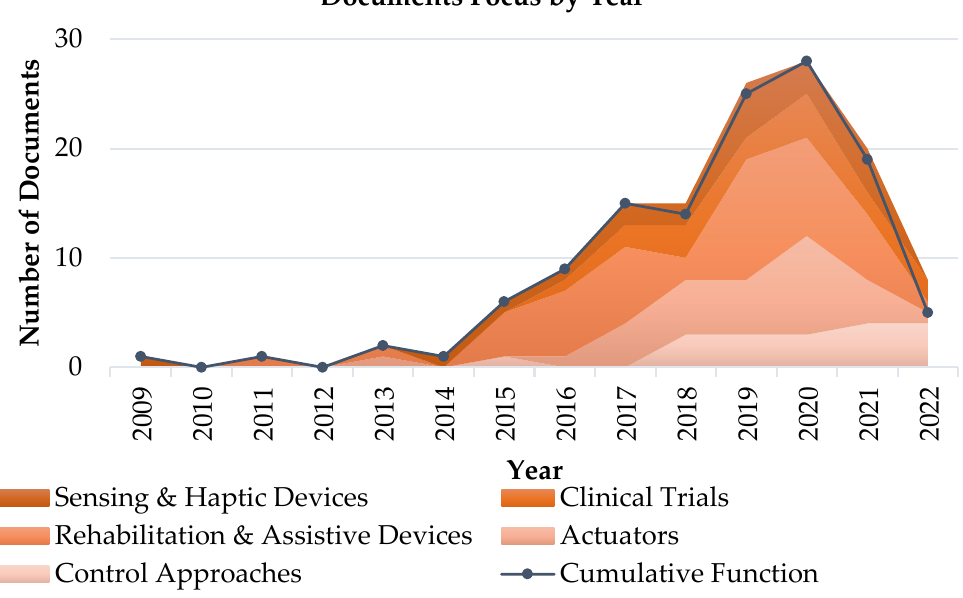
Figure 14. Evolution in time of the documents with respect to the device function. Data are presented in stacked format, with the total amount of documents for each year in black line with dots.